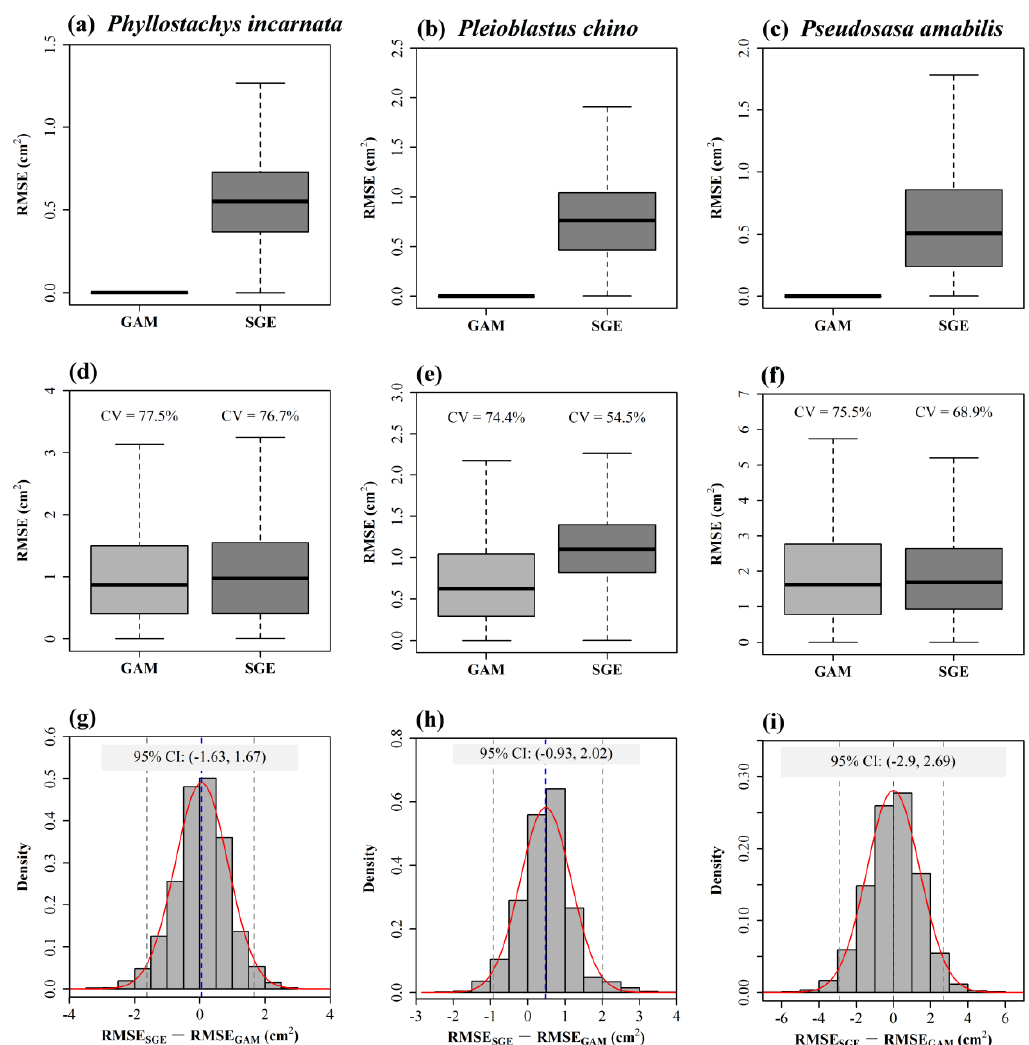
Figure 9. Comparison of the goodness of fit for two methods. Three datasets, each representing a species, were used. The GAM represents the generalized additive model, and the SGE represents the simplified Gielis equation. CV represents the coefficient of variation in root mean squared error (RMSE). To test whether there is a significant difference in RMSE between the two methods, 3000 partitionings of the dataset were carried out using the golden ratio (38.2% for the training set and 61.8% for the test set) for each species’ dataset. Boxplots were obtained, based on these 3000 partitionings. Panels ( a – c ) represent the training sets, and panels ( d – f ) represent the test sets. Panels ( g – i ) exhibit the distribution of the differences in RMSE between the two methods based on the test set. The 95% confidence interval (CI) for each panel includes 0, which means that there was no significant difference in the goodness of fit between the two methods in predicting the leaf areas of the test set (see ref. [26]). However, there was an apparent significant difference in RMSE between the two methods based on the training set. The vertical blue dashed line represents the mean of the differences, and the two vertical gray dashed lines represent the 95% CI of the difference.